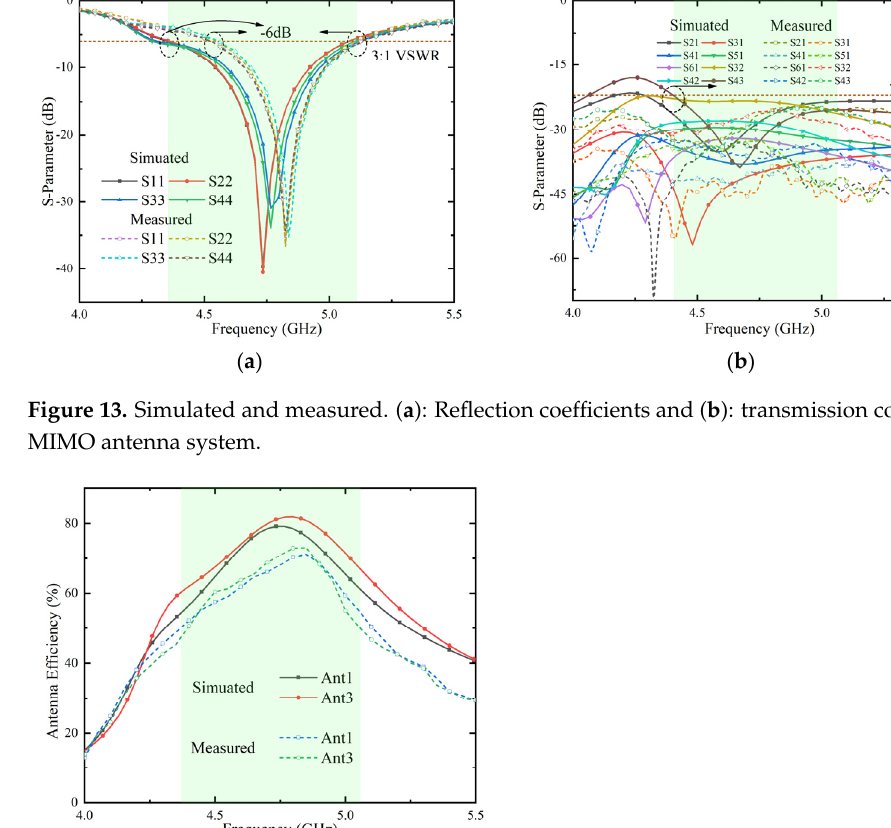
Figure 14. Simulated and measured antenna efficiencies.